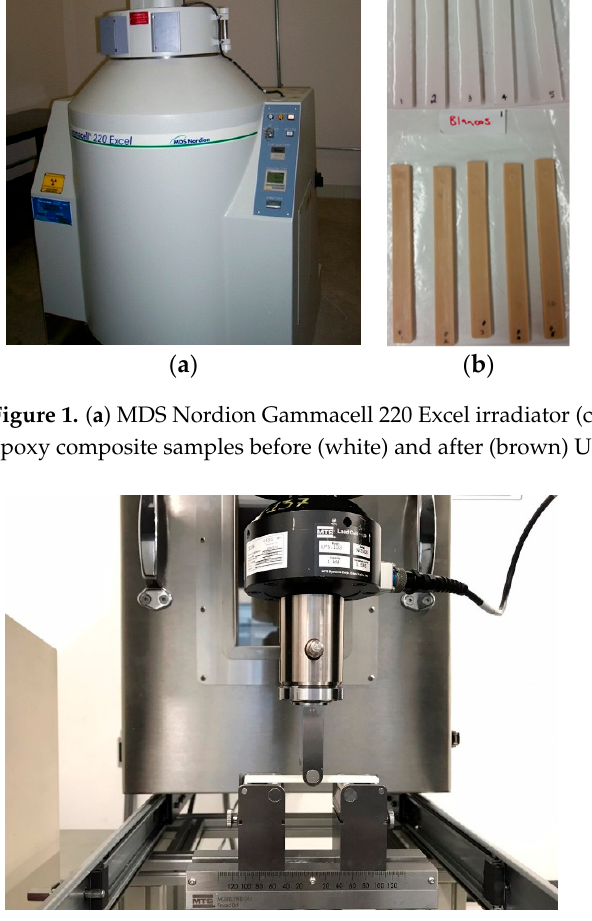
Figure 2. ASTM D7264 mechanical test of ZnO-epoxy composites.